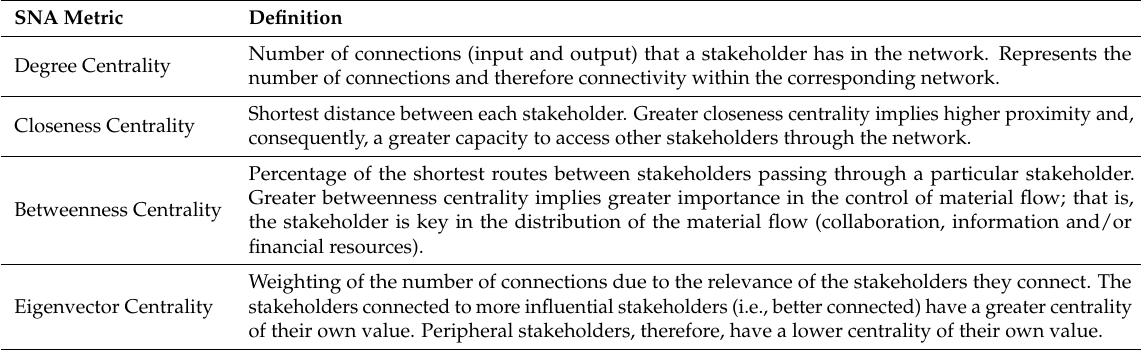
Table 1. SNA centrality metrics and definitions used in the analysis of basin-wide networks in the RRB.